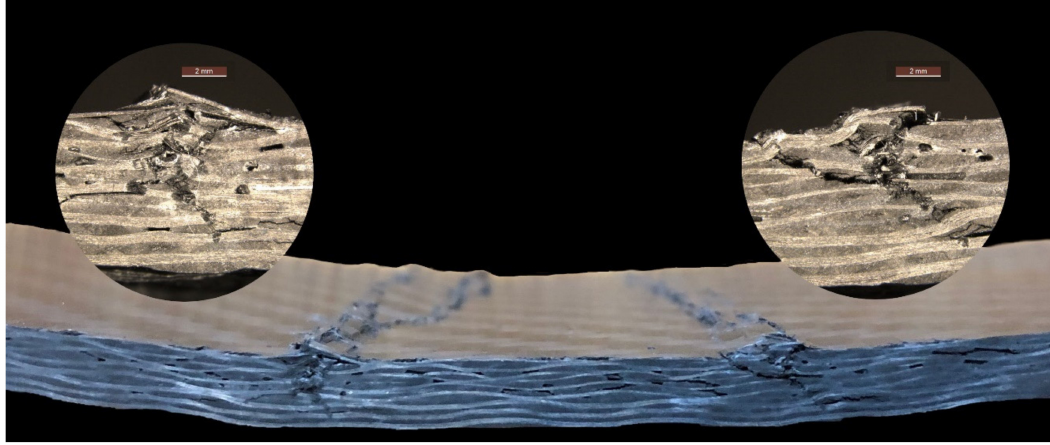
Figure 4. Magnification of intralaminar cracks: failure of the upper four